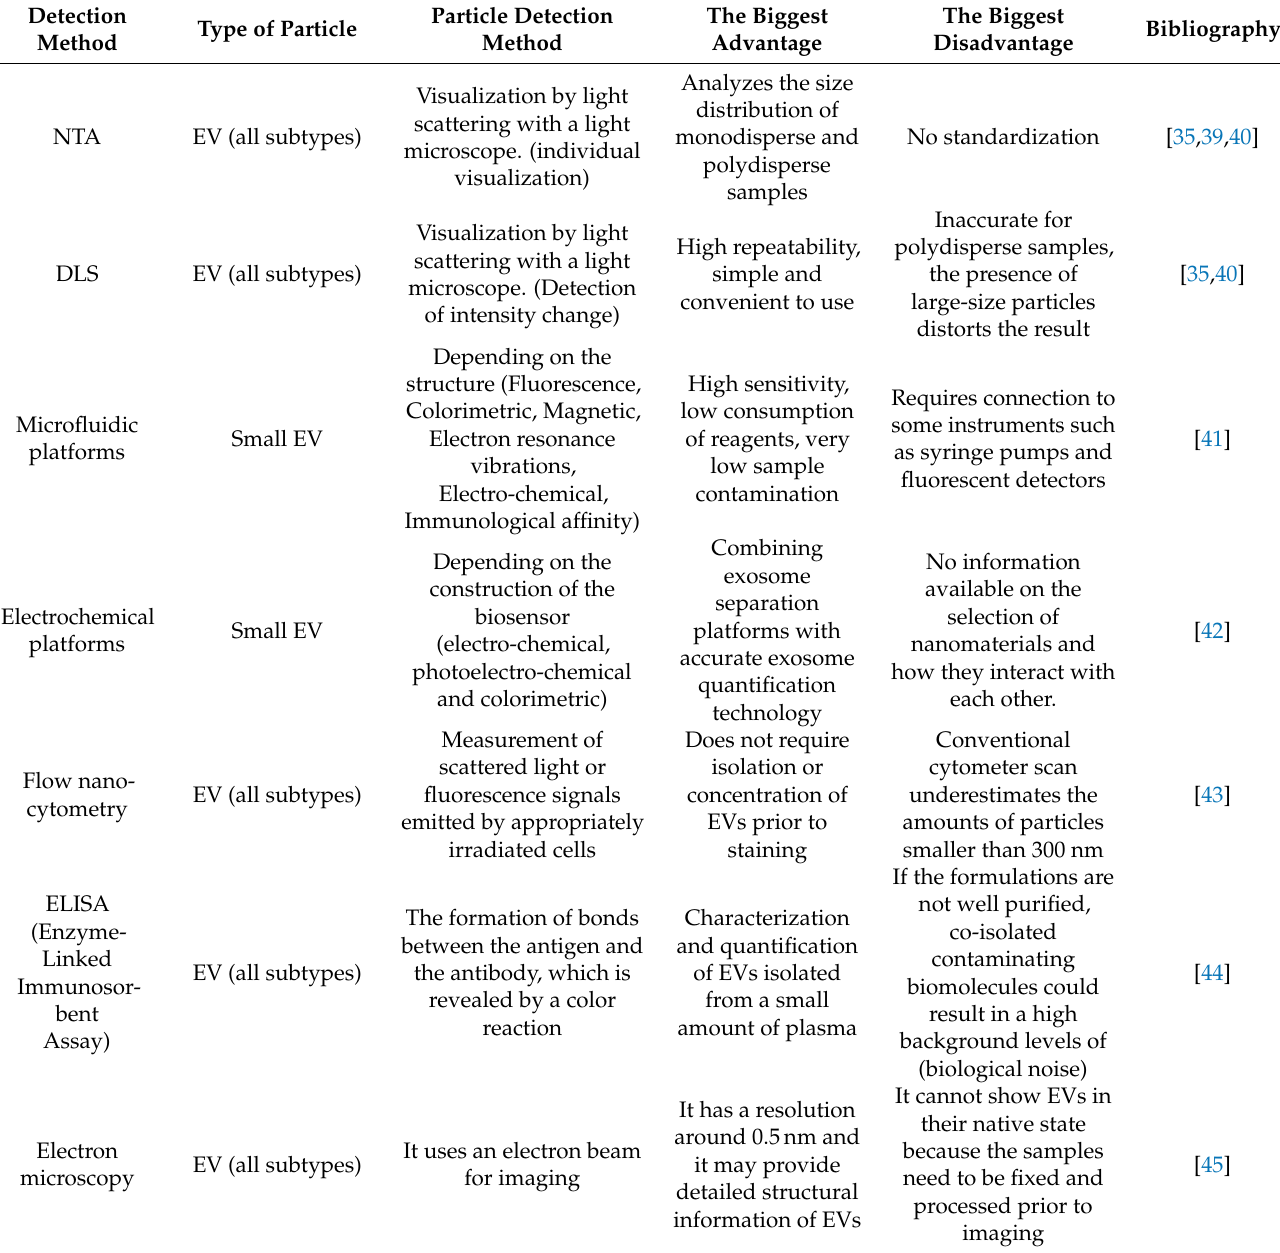
Table 1. Key information about methods of detecting extracellular